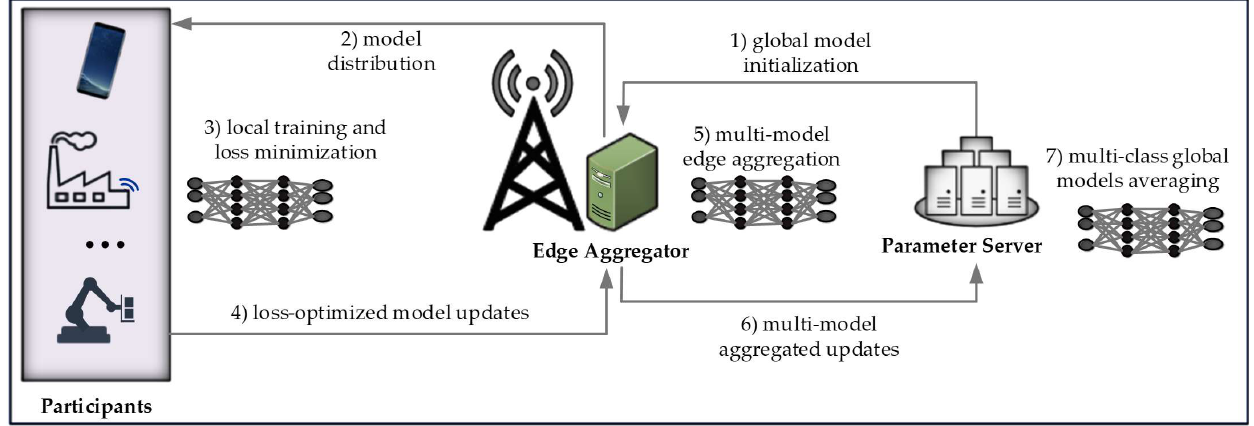
Figure 3. Transition procedures between participants, edge, and parameter server in edge FL.